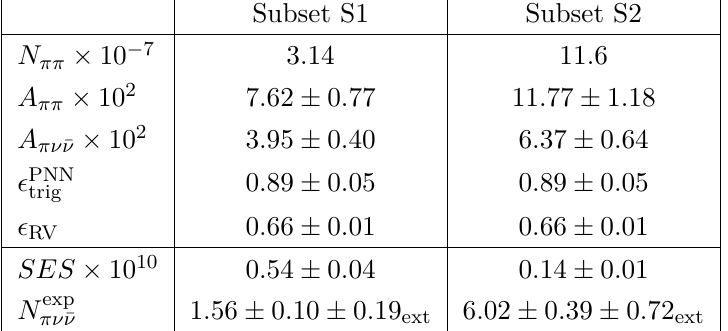
Table 1 . Inputs to the SES evaluation, SES values and numbers of expected SM signal events in the S1 and S2